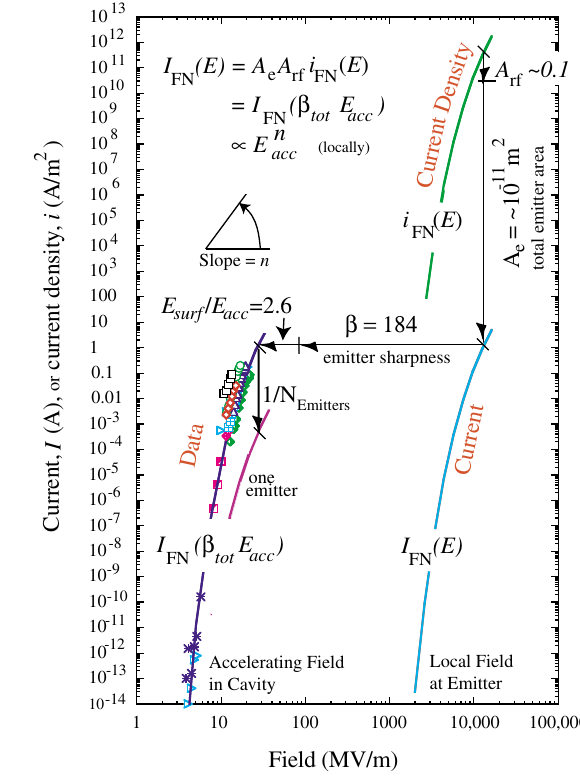
FIG. 4. (Color) The Fowler-Nordheim current density and the factors that determine the measured current, such as the cor- , the emitter area, A , the field rection for alternating fields, A e rf enhancements, and the number of individual